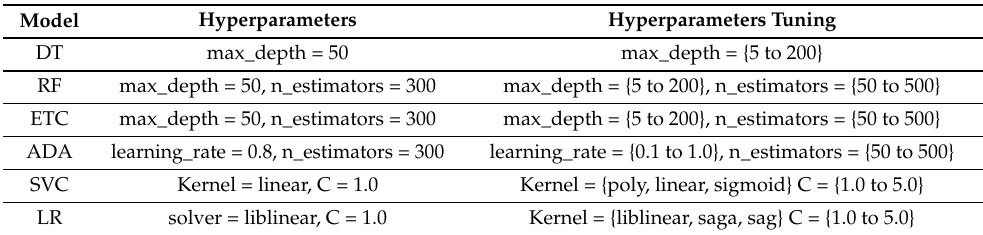
Table 5. Classifier hyperparameters setting for water quality prediction.